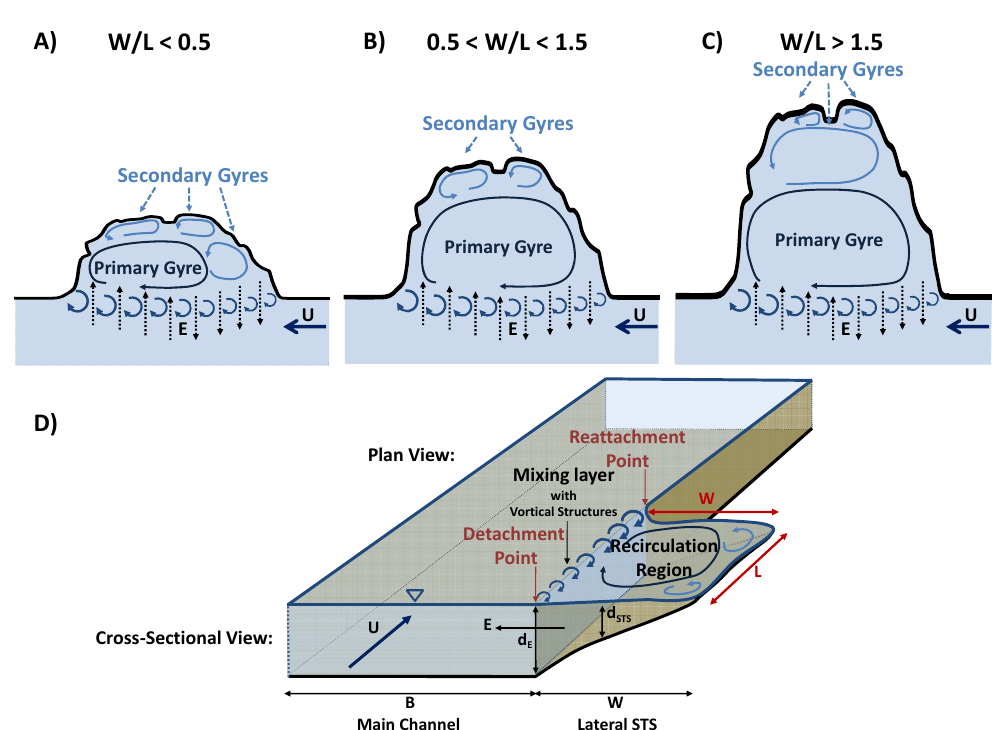
Fig. 2. Plan view schematics of the flow field for an emergent lateral cavity at three W/L aspect ratios and cross-sectional view schematic showing definition of hydromorphic